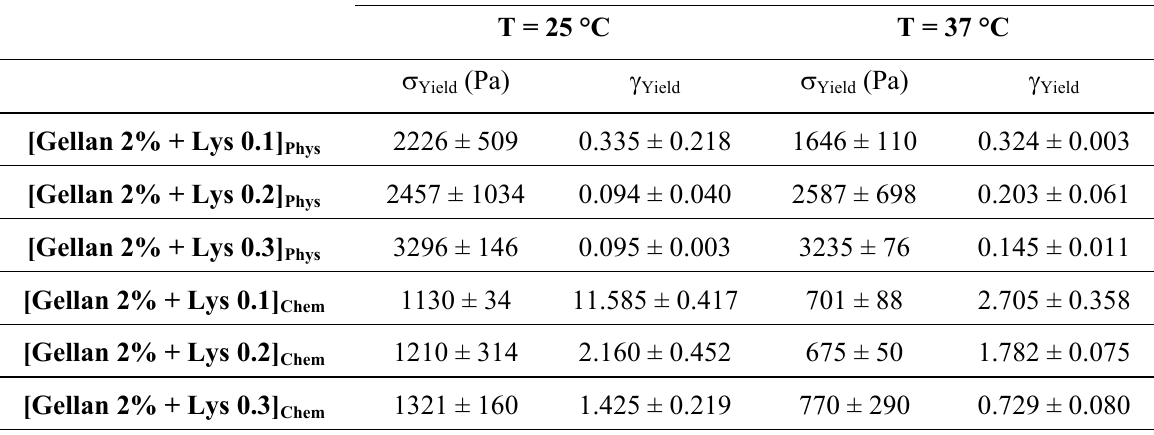
Table 2. Values of yield stress (  Yield ) and yield deformation (  Yield ) for the different hydrogels, obtained at 25 °C and 37 °C.